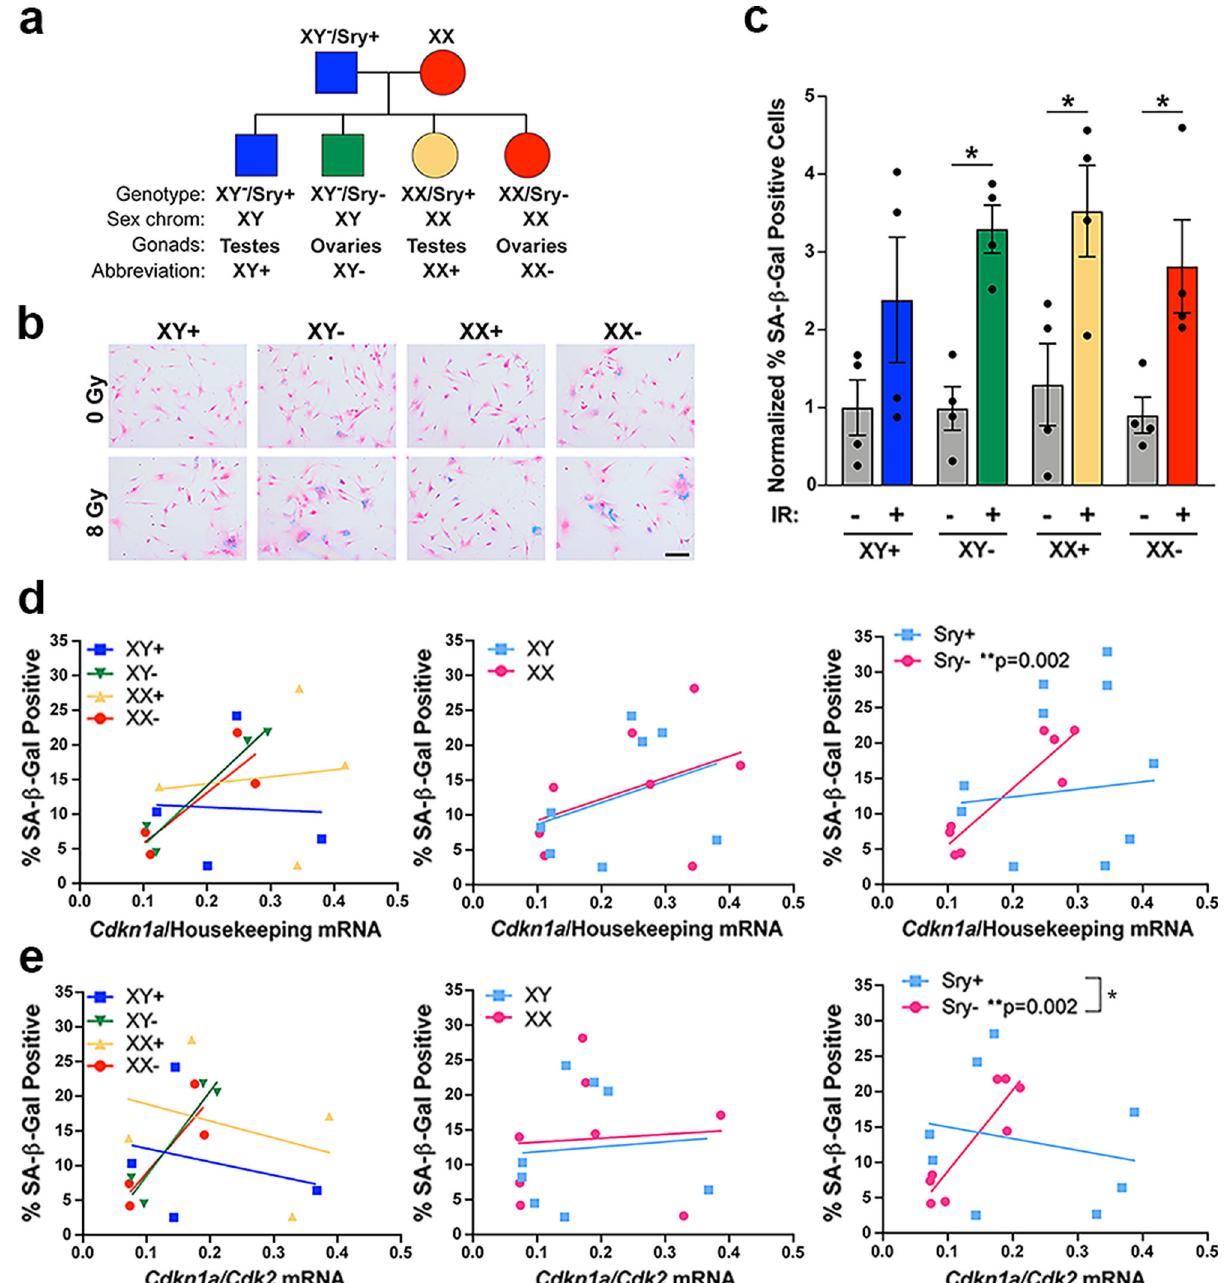
Fig. 8 Gonadal sex patterns the relationship between p21 and SA- β -gal positivity. a Diagram of the four genotypes resulting from the FCG mouse model. b Example images of FCG GBM model astrocytes stained for SA- β -gal 5 days after irradiation with 0 or 8 Gy, followed by counterstaining with nuclear fast red. Scale bar, 150 μ m. c Quanti fi cation of the percentage of SA- β -gal positive cells. Results are from two cell lines (each consisting of a corresponding XY + , XY − , XX + , and XX − line generated at the same time) tested in two separate experiments. Values were normalized to the XY + 0 Gy condition, which was arbitrarily set at 1. * p < 0.05 as indicated by bracket. Data are means + / − SEM ( n = 4/genotype/condition). d Correlation between Cdkn1a (p21) mRNA levels at 24 h after irradiation with 0 or 8 Gy and the percentage of SA- β -gal positive cells at 5 days after irradiation in FCG GBM model astrocytes, showing each genotype separately (left), as well as grouped by sex chromosomes (center) or gonadal sex (Sry status) (right). Sry + correlation: r = 0.13, p = 0.7617, Sry- correlation: r = 0.91, p = 0.0016 ( n = 8/group). e Correlation between the Cdkn1a/Cdk2 mRNA ratio at 24 h after irradiation with 0 or 8 Gy and the percentage of SA- β -gal positive cells at 5 days after irradiation in FCG GBM model astrocytes, showing each genotype separately (left), as well as grouped by sex chromosomes (center) or gonadal sex (Sry status) (right). Sry + correlation: r = − 0.22, p = 0.5964, Sry − correlation: r = 0.91, p = 0.002. Sry + slope vs Sry − slope: p = 0.0262 — indicated by bracket ( n =